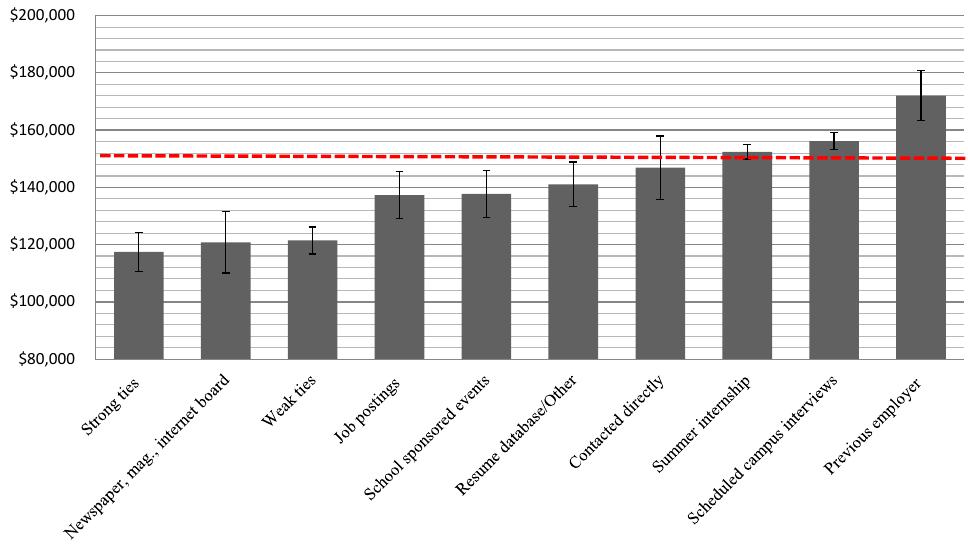
Figure 1: Mean Total Compensation (TC) Per Offer by Search Channel Note: Source: Proprietary data from a perennial top US business school. Vertical bars indicate the unadjusted mean total compensation (as applicable in US dollars: base salary, signing bonus, relocation aid, tuition reimbursement, current estimated value of stock options, and other guaranteed compensation) offered students by various job search channels. Dashed horizontal line represents the overall sample average. The unit of analysis is the job offer within and between students (N=740). Error bars represent standard